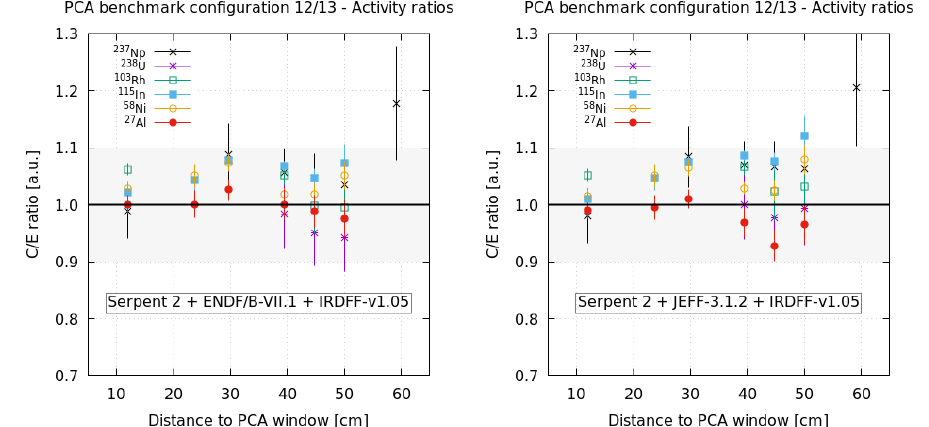
Figure 3 : Specific activity C/E ratios for the PCA case. Calculations with Serpent 2 were conducted using transport XS data from ENDF/B-VII.1 (left) and JEFF-3.1.2 libraries (right). Both cases use the